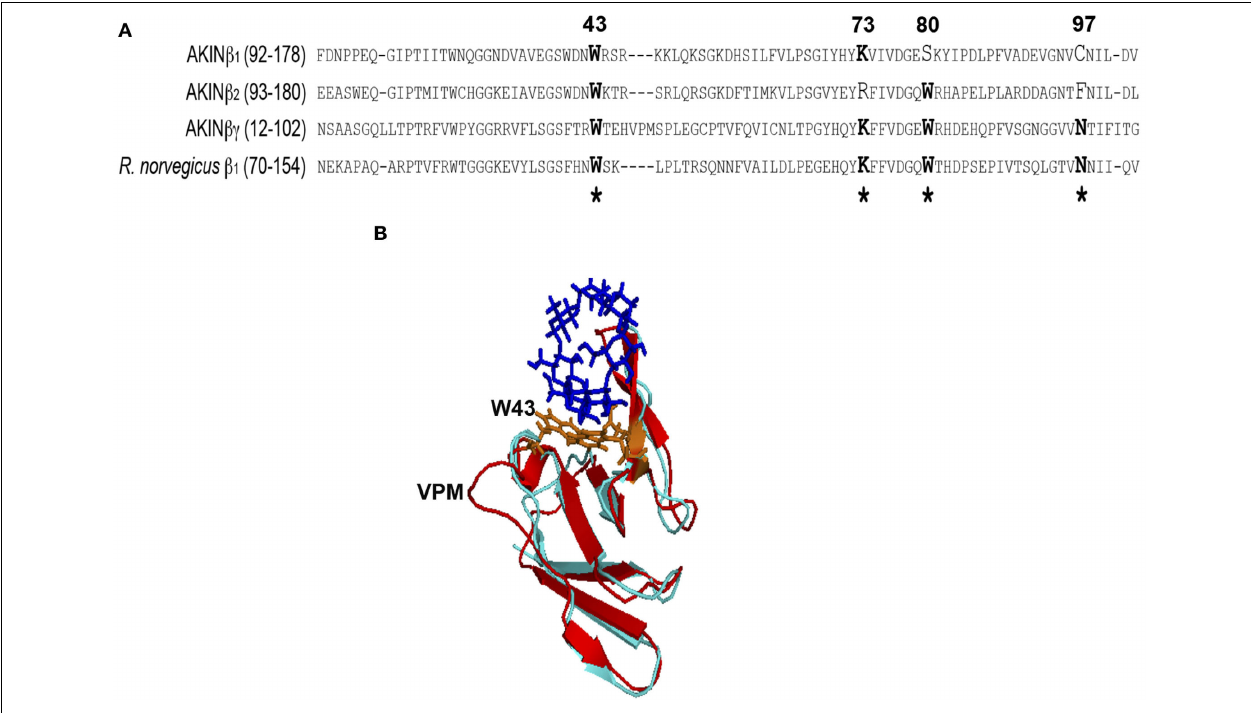
FIGURE 1 | Sequence and structural alignment. (A) Amino acids 92–178 from AKIN β 1, 93–180 from AKIN β 2, 12–102 from AKIN βγ and 70–154 from rat AMPK β 1 were included for the sequence alignment. The sequence identity with the Glycogen Binding Domain (GBD) of rat used to construct the structural model was 42%. (B) Lateral view of the structural alignment for the